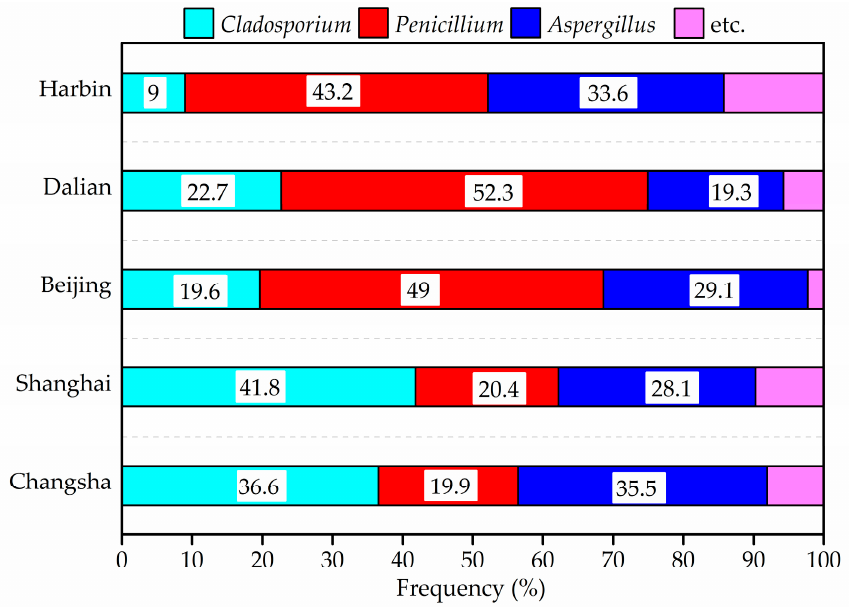
Figure 7. Frequency of airborne fungi species in indoor air in winter.